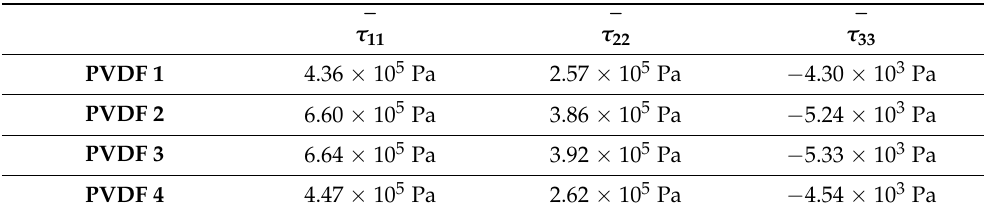
Figure 5. FE simulation ( a ) the in-plane strain distribution of the cylinder at 87 Hz and ( b ) the internal in-plane stress field of the cylinder. Table 2. Averaged volume averaged stresses applied on PVDF elements at 87